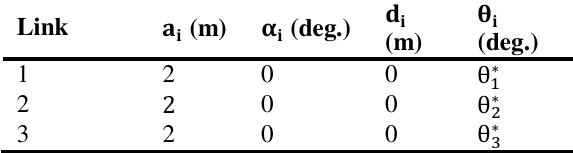
Link parameter table of forward kinematics for three link